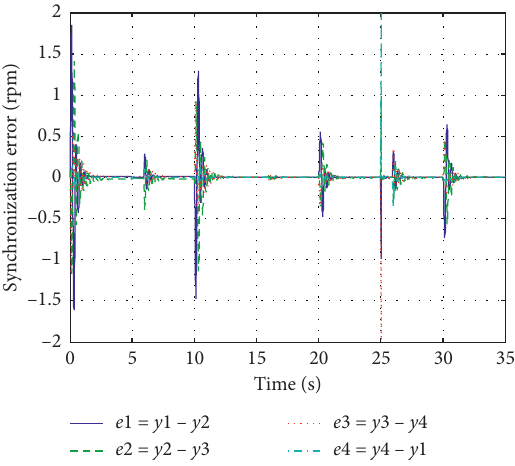
Figure 11: Synchronization error of FTC.